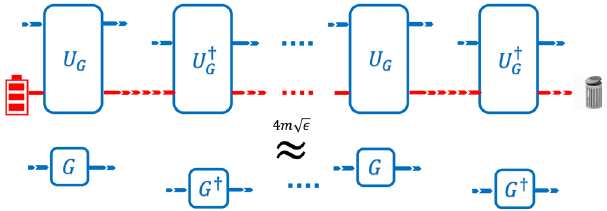
FIG. 3. Approximating m uses of a gate and its inverse. If a unitary gate G can be implemented with small error, then the battery can be reused 2 m times, approximately implementing m uses of the gates G and G † . As a consequence, the state of the battery should be able to provide m times the maximum resource generation of G and G † up to a